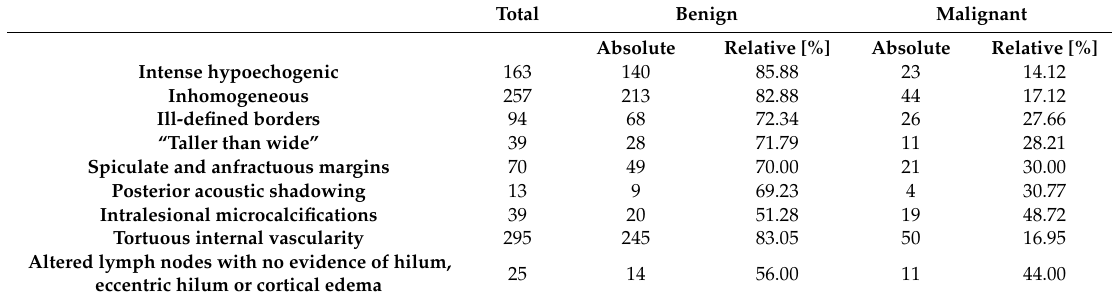
Table 2. Conventional breast ultrasound malignancy markers and malignancy (1405